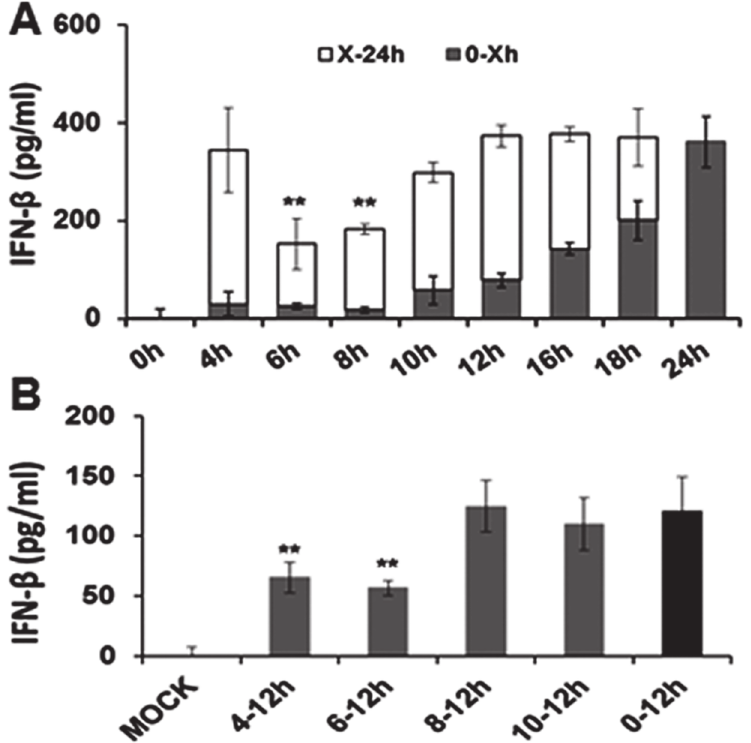
Fig 1. Kinetics of IFN- β production in C . muridarum -infected Bm1.1 OE cells. (A) Bm1.11 cells were infected with 10 IFU/ cell C . muridarum to measure the amount of IFN- β secreted into the supernatants for 24 hours. The supernatants were collected from the infected cells at each time point listed (denoted as 0-Xh), and replaced with fresh medium for the remainder of the 24 hour infection (denoted as X-24h). Total IFN- β secreted in the supernatants of the two phases was measured by ELISA. (B) Bm1.11 cells were infected with 10 IFU/cell C . muridarum to measure only the residual amount of IFN- β secreted into the supernatants after the media was replaced. Each time interval shows residual amounts of IFN- β synthesis up until 12hr post- infection. Horizontal bars represent mean ± SD of cytokine levels from experiments performed in triplicate. Results are representative data from one of three independent experiments . ** = p < 0 . 01 compared to 24h C . muridarum infection control .